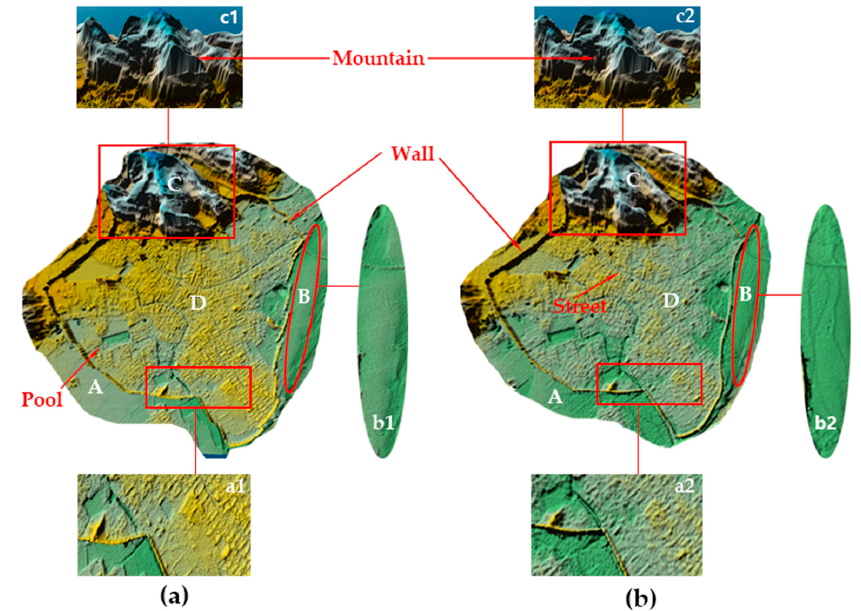
Figure 4. Shaded relief images generated with bathymetric data acquired by MBES in 2002 ( a ) and 2015 ( b ).